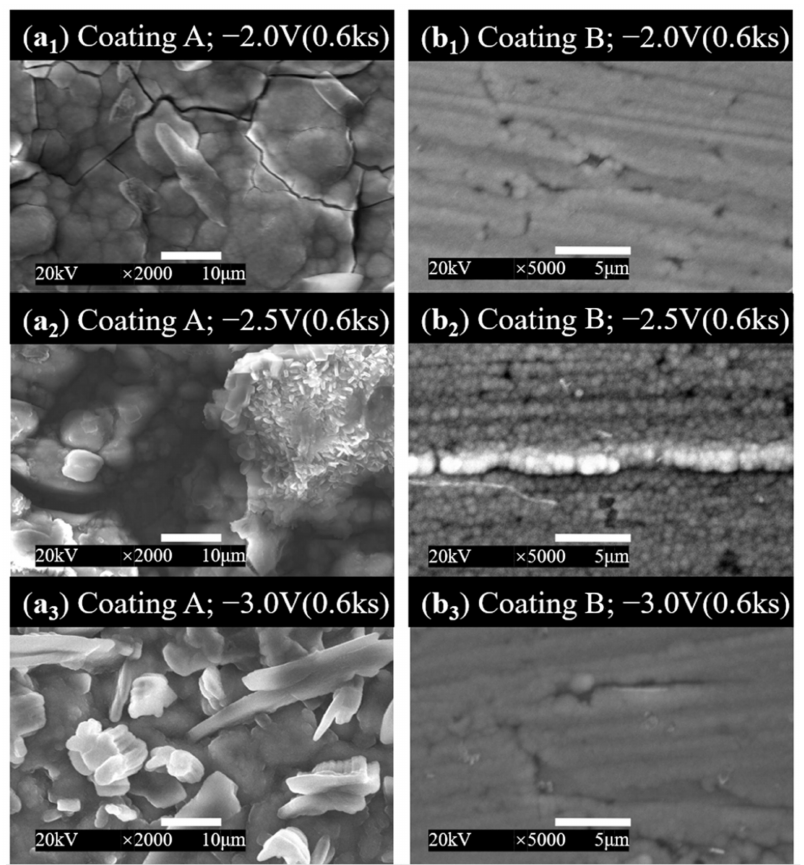
Figure 3. Surface morphologies of coatings A ( a 1 – a 3 ) and B ( b 1 – b 3 ) deposited at − 2.0 V, − 2.5 V, and − 3.0 V (vs. SSE) for 0.6 ks.